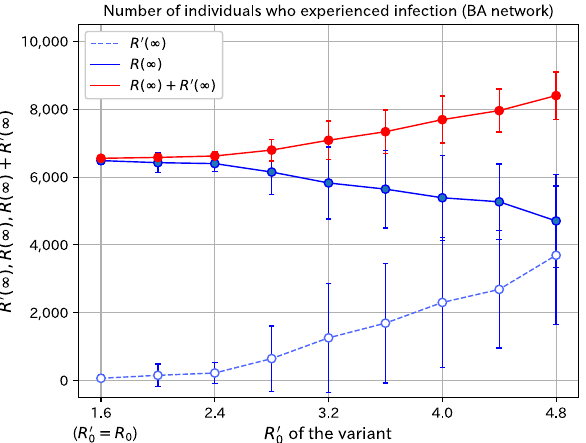
Figure 8. Dependence of the final number of infected individuals on R ′ 0 of the variant. The infectivity of the variant is the same as that of the original virus for R ′ 0 = 1.6